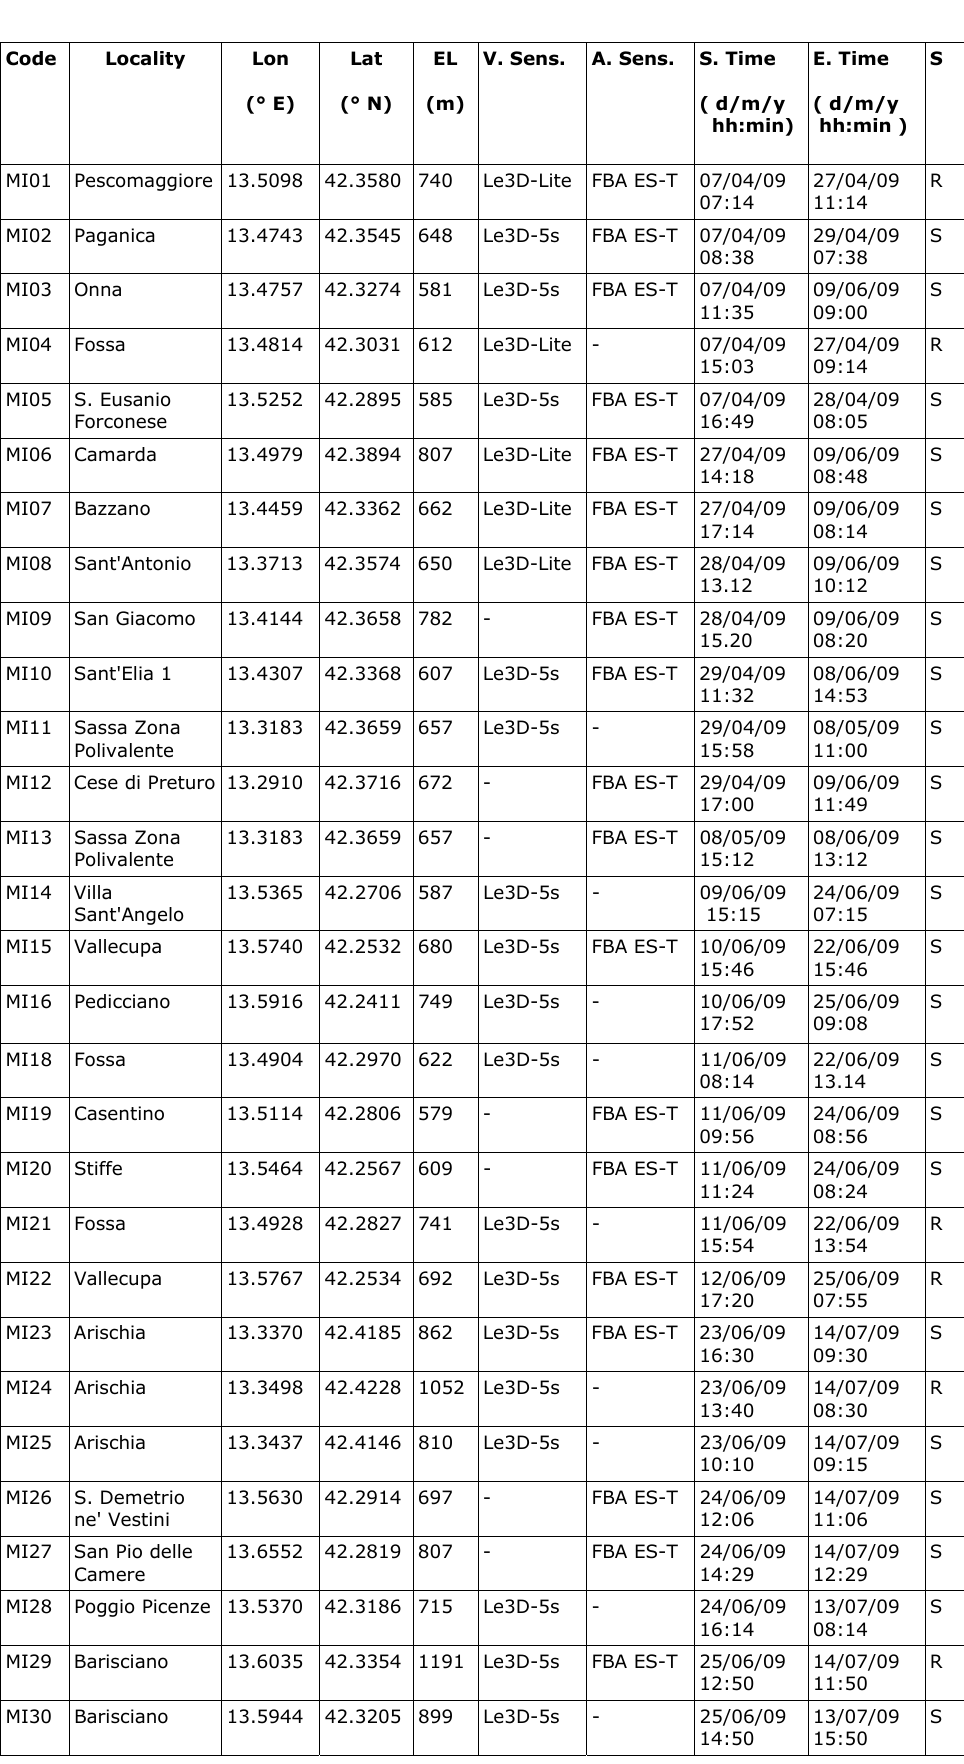
Table 2. The RAIS temporary stations. In the last column a preliminary soil ( S ) classification is reported ( R = rock and S = soft). V. Sens. and A. Sens. indicate velocimetric and accelerometric sensors respectively. S. Time is the starting time, E. Time is the ending time. Lon , Lat and EL indicate Longitude, Latitude and